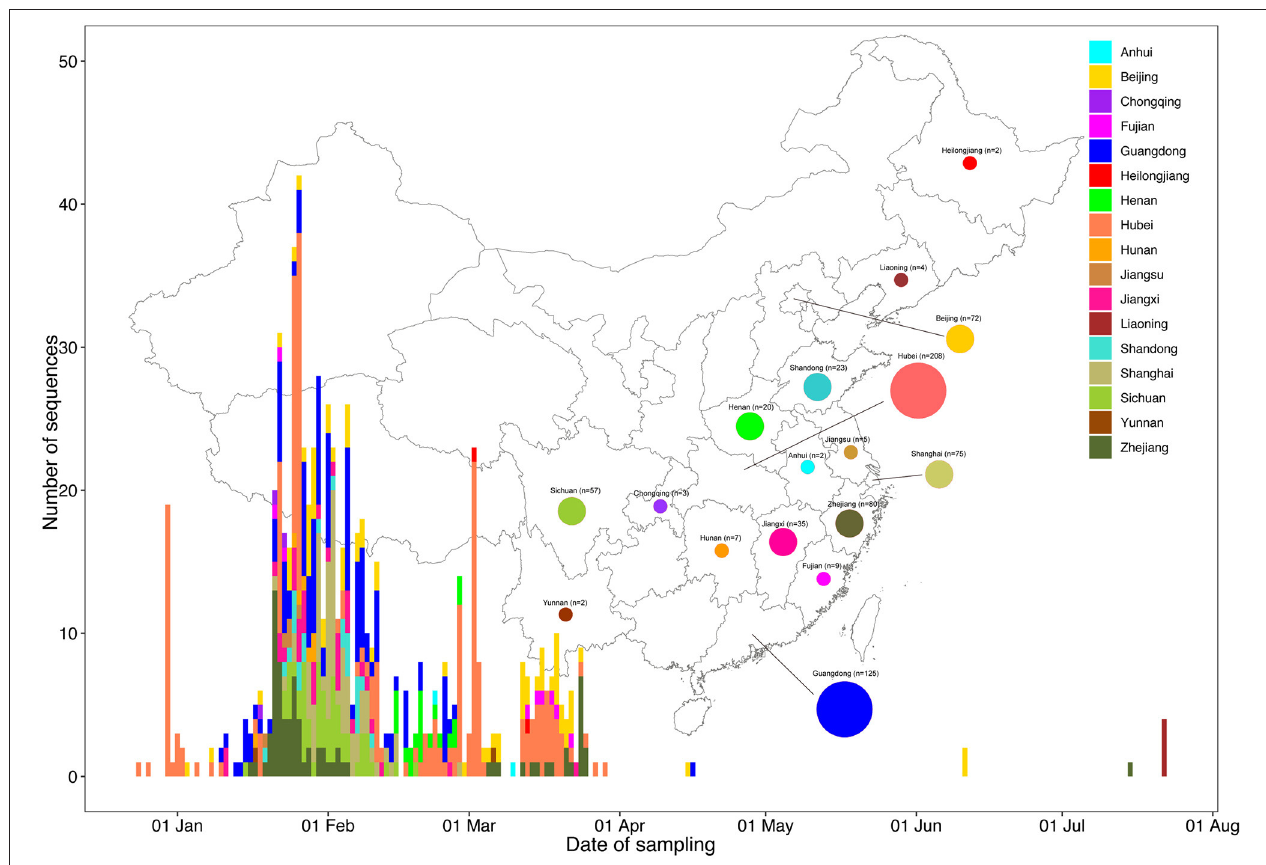
FIGURE 2 | Time series and geographic distribution of the 729 SARS-CoV-2 genomes from Mainland China by sampling date. The geographic distribution of the 729 SARS-CoV-2 genomes from Mainland China in the present study is shown at the provincial level. Colors indicate different sampling provinces from Mainland